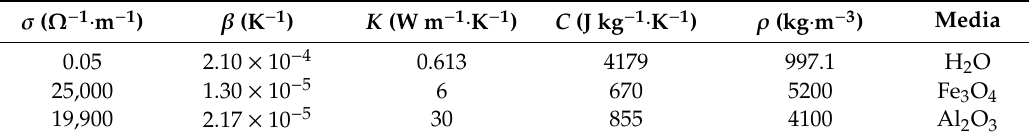
Table 4. Physicochemical properties of H 2 O with Fe 3 O 4 and Al 2 O 3 nanoparticles.